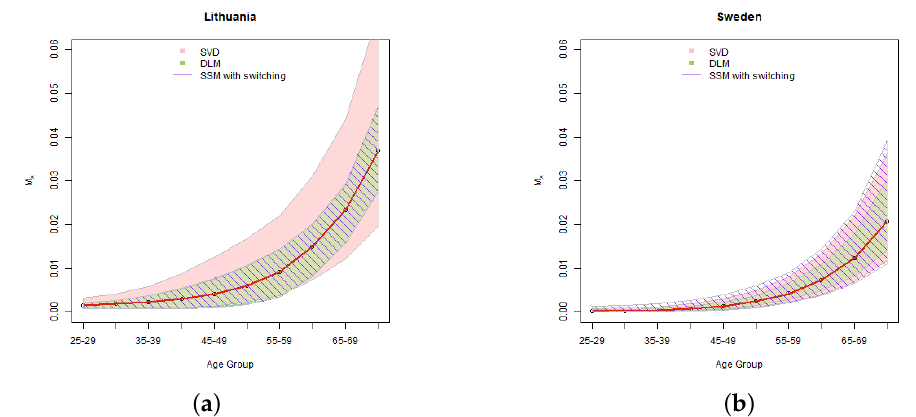
Figure 8. Results of simulation of 15 year projection of mortality rates for ages from 25 to 74 for Lithuania ( a ) and Sweden ( b ). The shaded region provides 99.5% simulated confidence intervals of the projected mortality rates fitted using SVD, DLM and SSM with